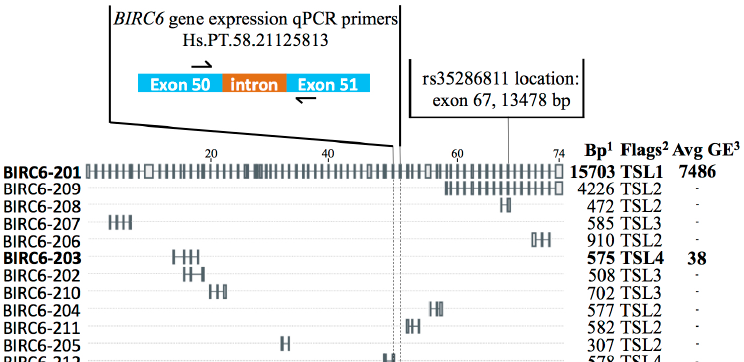
Figure 1. BIRC6 gene structure. Known BIRC6 isoforms and their exon composition are indicated based on the ENSEMBL database, with flags on the right indicating transcript support level (TSL; TSL1 is the highest score where all splice junctions of the transcript are supported by at least one non-suspect